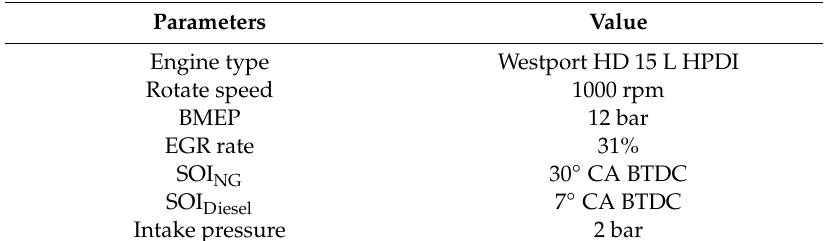
Table 6. Experimental data calibration parameters.